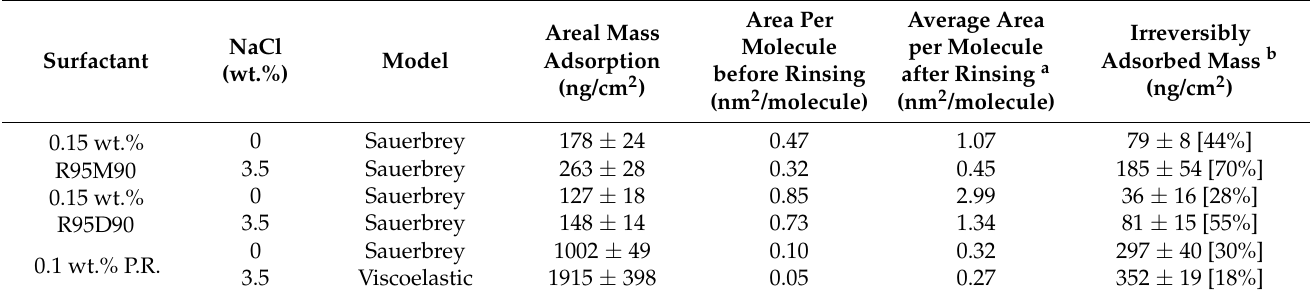
Table 2. Adsorption properties of rhamnolipids adsorbed from aqueous solutions on gold surfaces during QCM-D